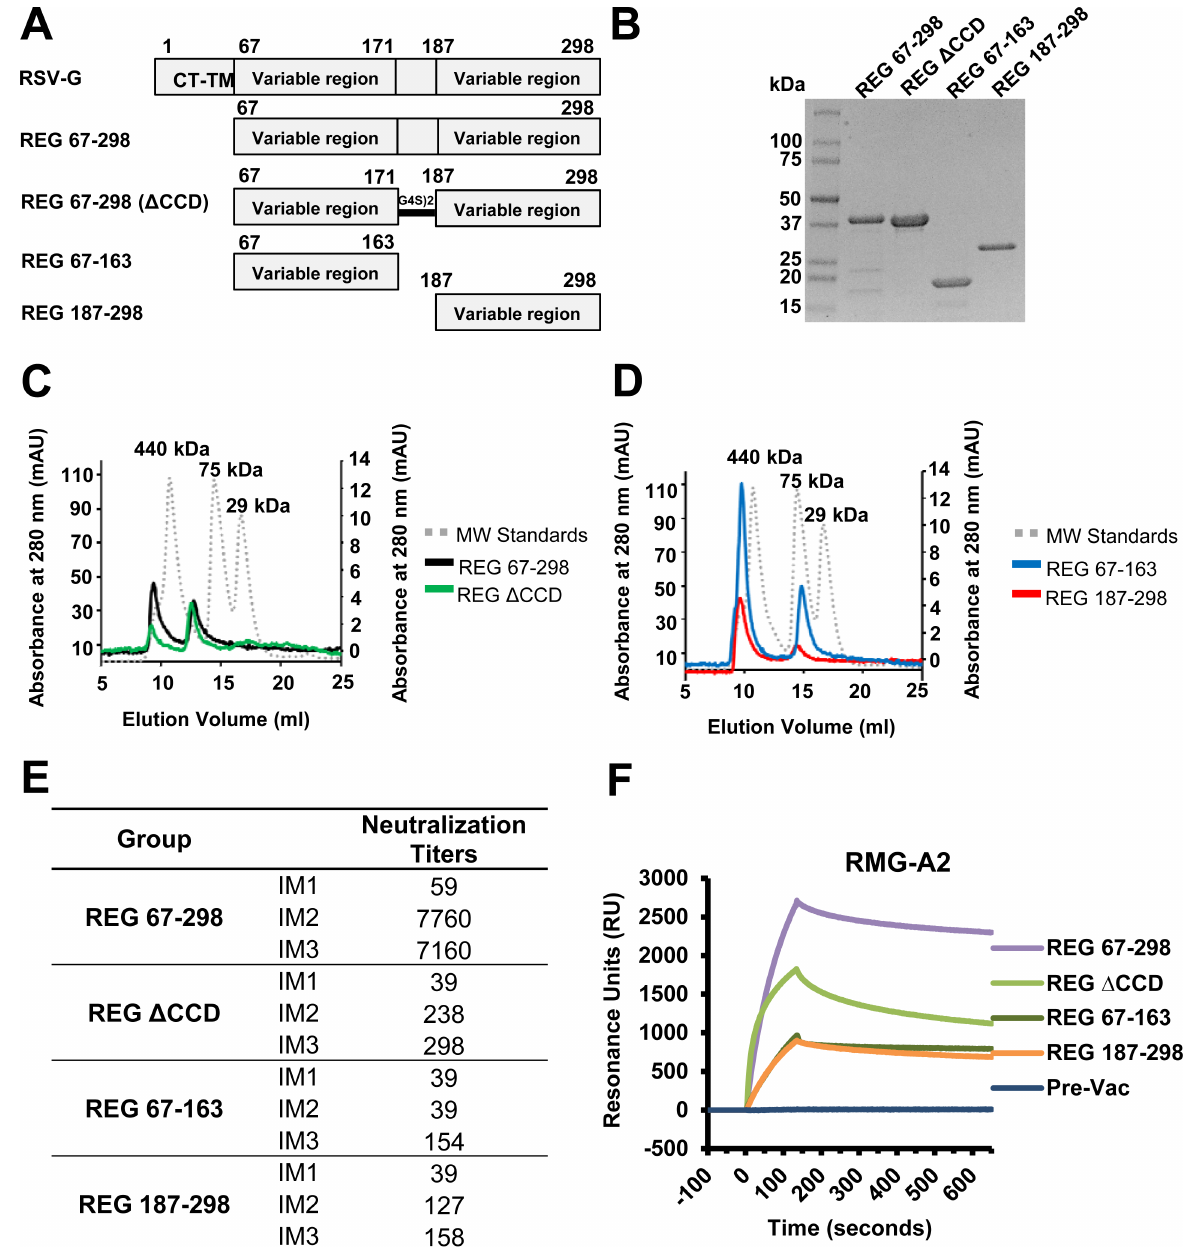
Fig 1. Recombinant G proteins produced in E . coli . (A-B) Schematic representation of the RSV G protein and subdomains. RSV G ectodomain lacks the cytoplasmic and transmembrane domains (CT-TM) and is not glycosylated (REG) since it is produced in E . coli . REG 67–298, REG 67– 298 with aa 172–186 deleted (REG Δ CCD), REG N-terminus (aa 67–163), and REG C-terminus (aa 187–298), all containing 6x His tag at C- terminus, were expressed in E . coli and purified using a Ni-NTA column, and subjected to SDS-PAGE under reducing conditions. (C-D) Superdex 200 10/300 gel filtration chromatography of RSV G proteins produced in the bacterial system (REGs). Elution profiles of purified REG 67–298 (indicated by black line) and REG Δ CCD (green) (C), REG 67–163 (blue) and REG 187–298 (red) (D) are overlaid with molecular weight standards (gray dotted line). (E) Neutralizing antibody response following REG 67–298, REG Δ CCD, REG 67–163, and REG 187–298 immunizations in rabbits by PRNT assay. Serum samples were collected from individual rabbits 8 days after the first (IM1), second (IM2), and third (IM3) immunizations, and were tested for neutralization by PRNT against the RSV A2 strain. Neutralizing antibody titers represent 50% plaque inhibition. (F) SPR analysis of post-third vaccination serum antibodies (diluted 10-fold) binding to fully glycosylated G ectodomain RMG from RSV-A2